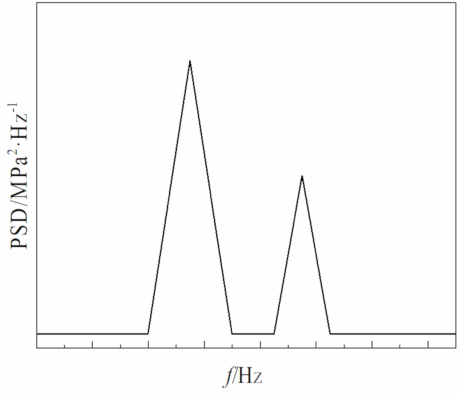
Figure 2. Double peak simulation